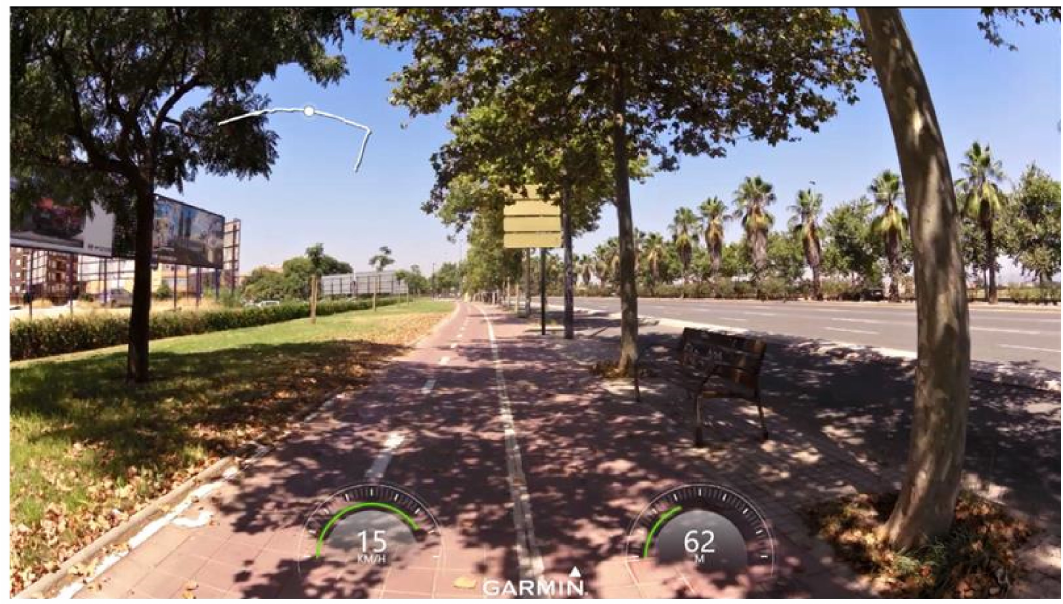
Figure 12. Screenshot from VIRB Edit